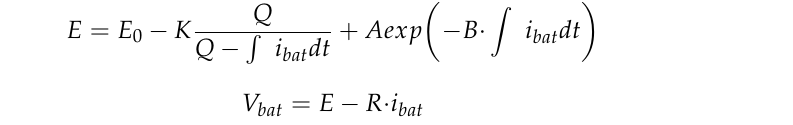
Figure 1. The topology of HESS with PV.